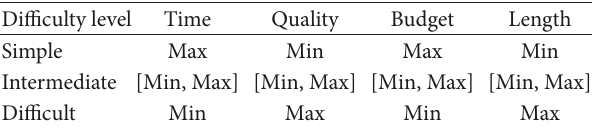
Table 3: Example of three mission